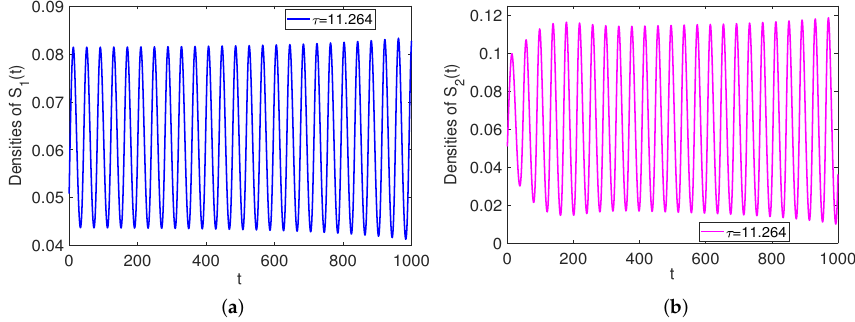
Figure 13. ( a ) The trajectory of S 1 ( t ) with τ = 11.264. ( b ) The trajectory of S 2 ( t ) with τ =